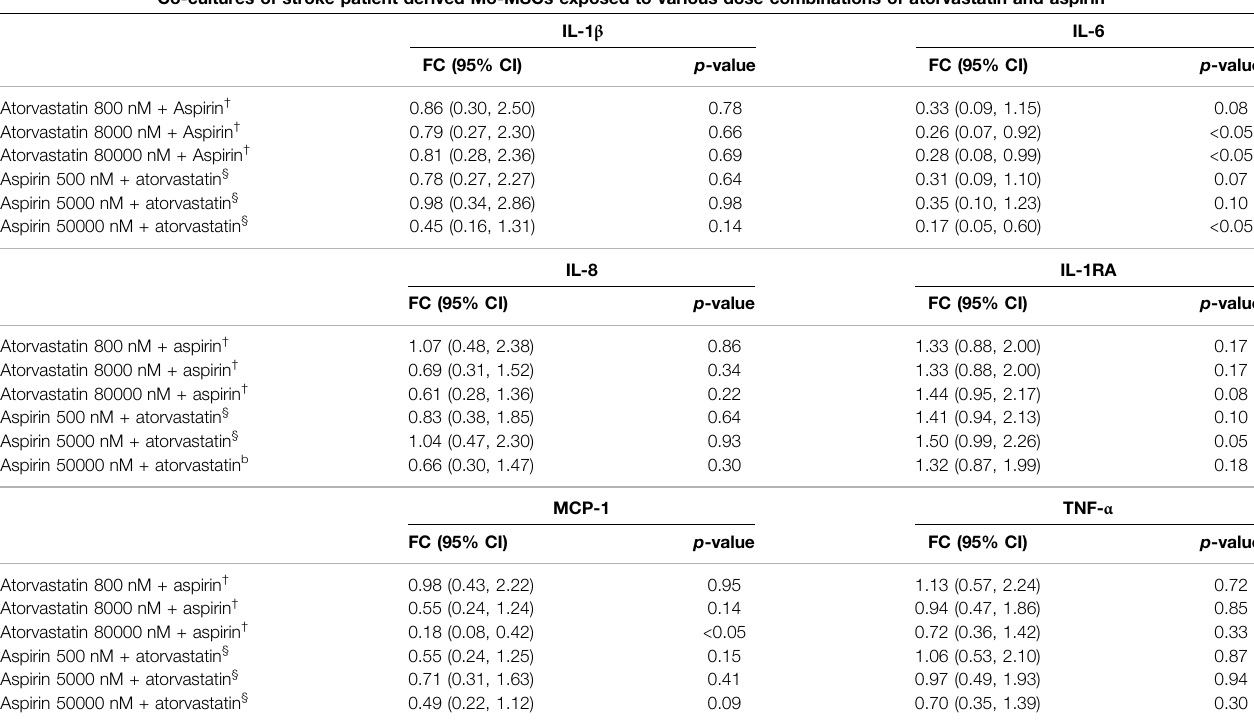
TABLE 3 | Estimated fold changes to secretome from co-cultures of stroke patient derived Mo and MSCs after exposure to combination of atorvastatin and Aspirin with respecttoavehiclecontrolofatorvastatin0+Aspirin0 nM.CombinationofatorvastatinandAspirindecreasestheIL-6secretionfromstrokeMo-MSCsco-culturesafter 24 h of exposure. In addition, there is also a decrease in MCP-1 secretions at the highest dose of atorvastatin and aspirin after 24 h of exposure. Signi fi cance is shown by p -value < 0.05. FC (cid:2) Fold Change, 95% CI (cid:2) 95% Con fi dence Intervals with lower and upper limits. Co-cultures of stroke patient derived Mo-MSCs exposed to various dose combinations of atorvastatin and